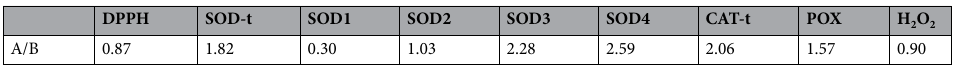
Table 4. Differences between hybrid females in selected parameters of the antioxidant system. A T × NC(f), B NC × T(f), SOD-t total SOD, CAT-t total CAT.